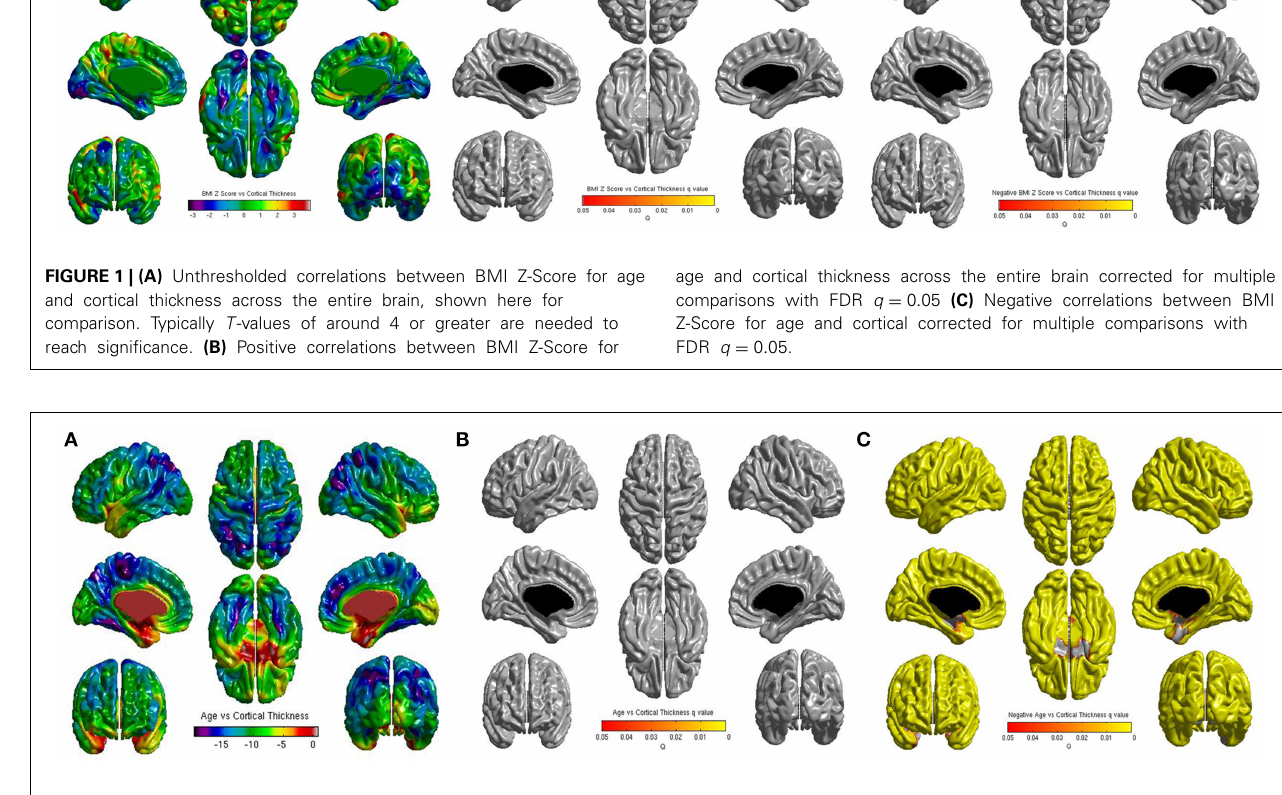
corrected for multiple comparisons with FDR q = 0 . 05 . (C) Negative correlations between age and cortical thickness across the entire brain